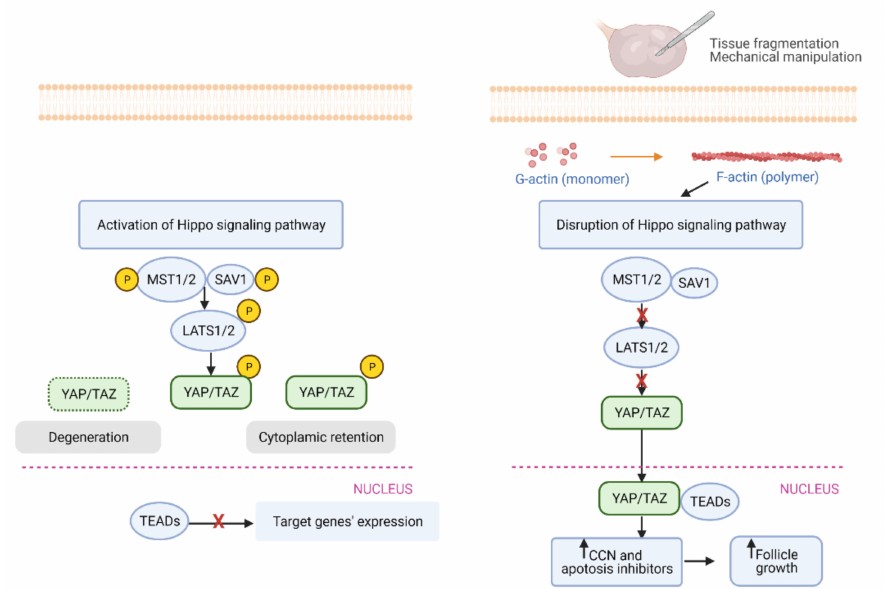
Figure 3. Tissue fragmentation and mechanical manipulation disrupt ovarian Hippo signaling pathway and promote follicle growth. ( Left ) Without tissue fragmentation and mechanical manip- ulation, Hippo signaling is activated. Kinase complexes consisting of the mammalian sterile-20 like serine/threonine kinase 1/2 (MST 1/2) and Salvador (SAV) are phosphorylated. Subsequently, large tumor suppressor 1/2 (LATS1/2) phosphorylates Yes-associated protein (YAP)/ transcrip- tional co-activator PDZ-binding motif (TAZ), leading to the degradation of YAP/TAZ or retention of YAP/TAZ in the cytoplasm. Consequently, transcriptional enhanced associate domains (TEADs) cannot promote the expression of target genes. ( Right ) Ovarian fragmentation leads to actin poly- merization, resulting in nuclear translocation of YAP. Nuclear YAP interacted with TEADs to increase the expression CCN growth factors and baculoviral inhibitors of apoptosis repeat containing (BIRC) apoptosis inhibitors, resulting in follicle